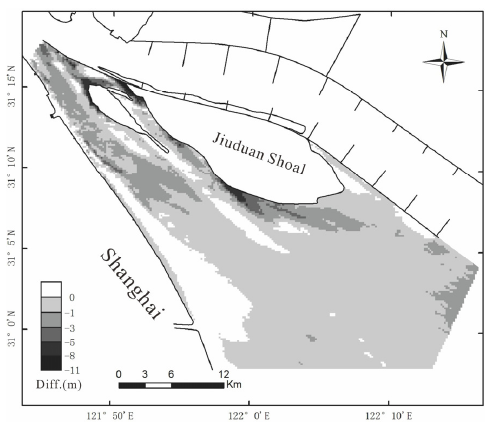
Figure 6. Thickness of deposition or erosion in the South Passage from 2002 to 2013 (negative values indicate net erosion; while positive values indicate net accretion).